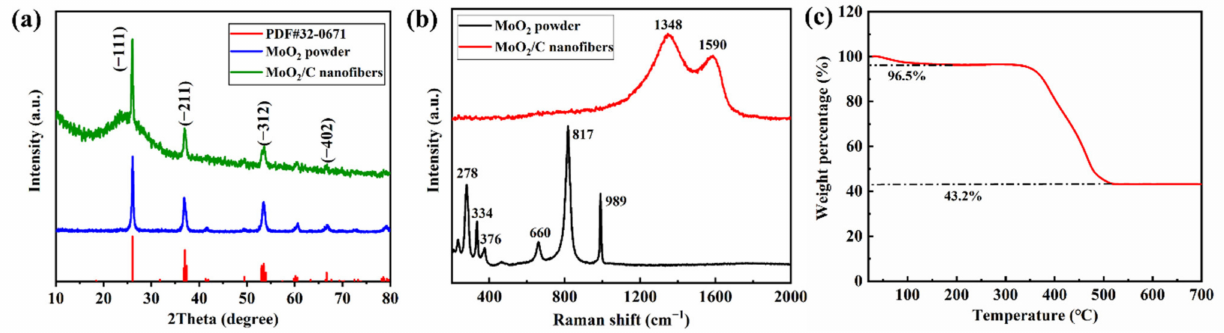
Figure 3. ( a ) XRD patterns of MoO 2 /C nanofibers and pure MoO 2 particles; ( b ) Raman spectra of MoO 2 /C nanofibers and pure MoO 2 particles; ( c ) Thermogravimetric analysis (TG) curves of MoO 2 /C nanofibers materials in air